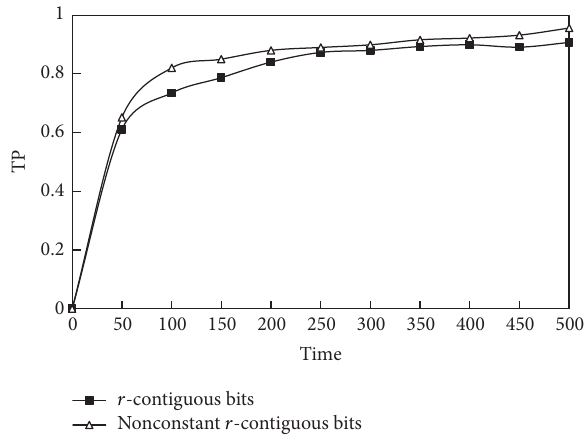
Figure 1: The nonself detection rate of two matching algorithms.